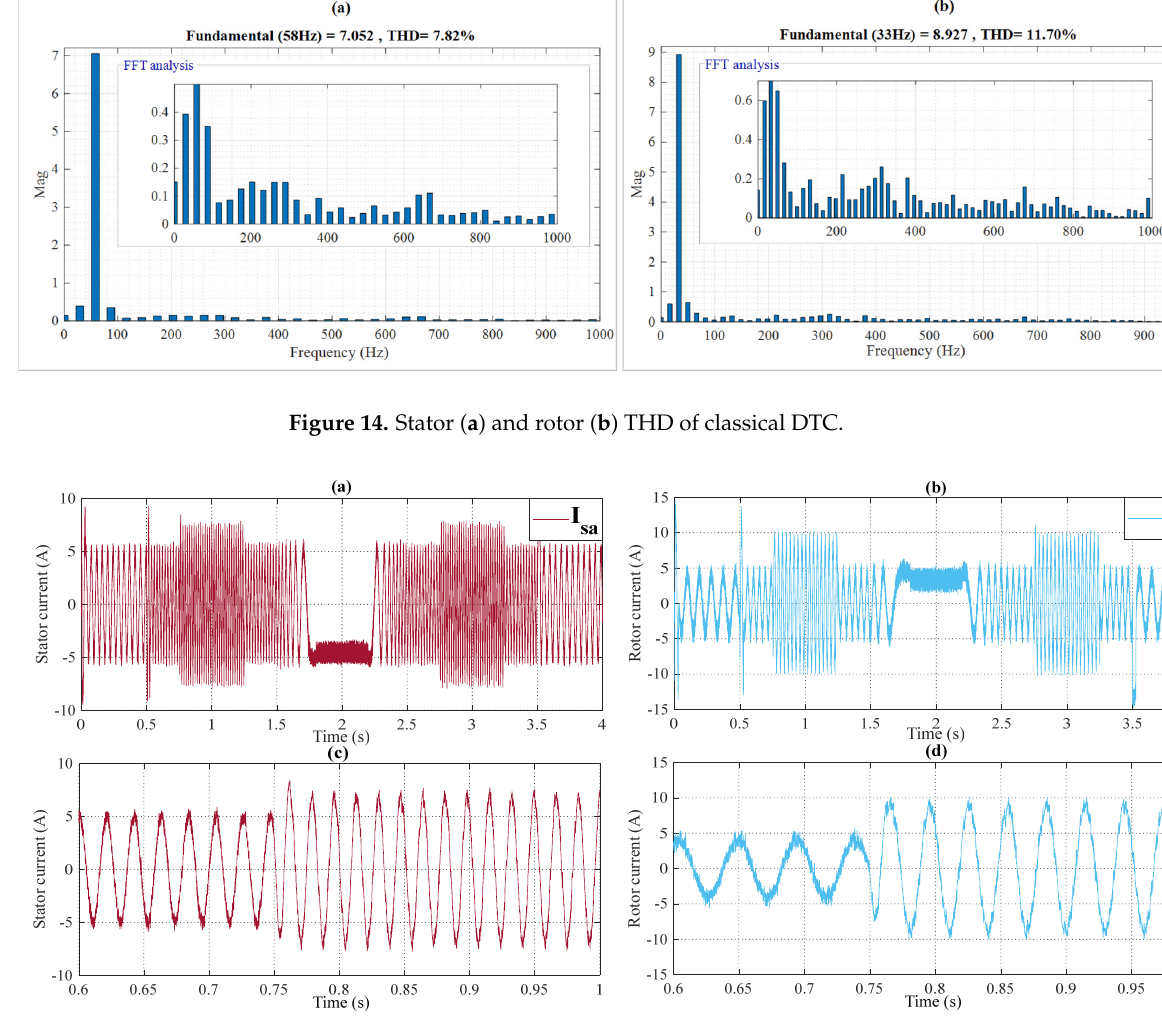
Figure 15. Stator ( a , c ) and ( b , d ) rotor currents responses of intelligent ACO-DTC.